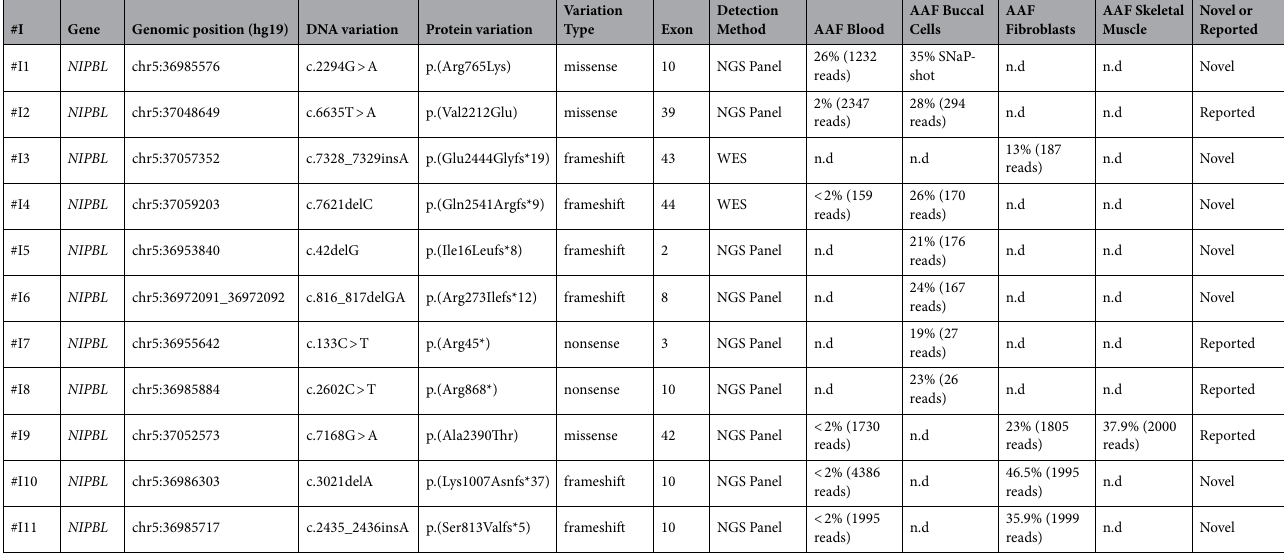
Table 2. Molecular findings of the 11 reported individuals with NIPBL mosaic variants. NIPBL RefSeq NM_133433. Total number of reads is indicated. Abbreviations : I, Individual; AAF, alternative allele frequency; n.d., not